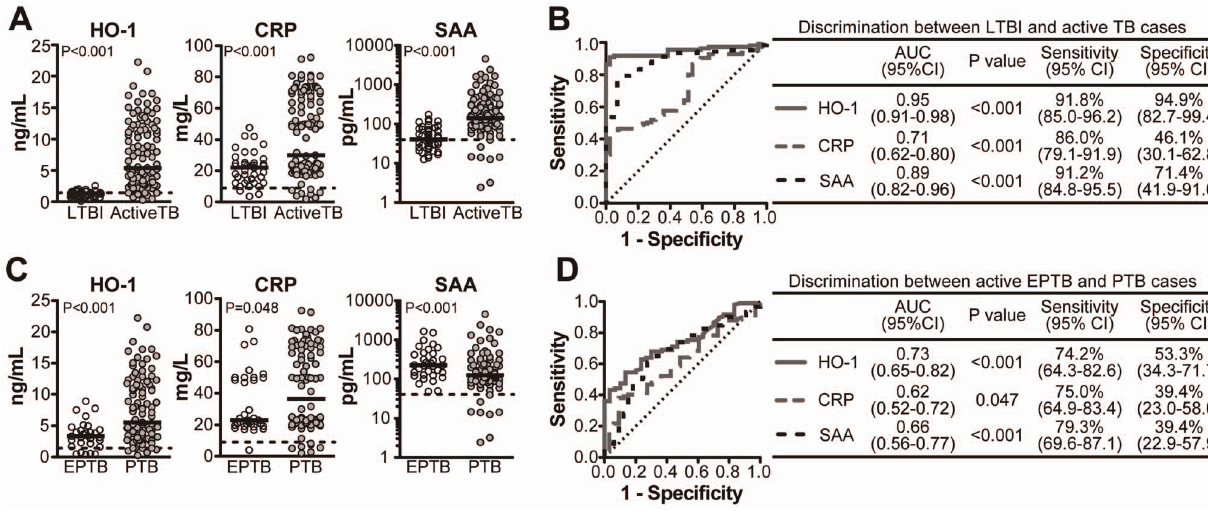
Figure 2. HO-1 as a candidate marker of active pulmonary tuberculosis. Levels of HO-1, C-reactive protein (CRP) and Serum Amyloid Protein-A (SAA) were compared between individuals with LTBI and active TB ( A ) or between patients with active EPTB and those with PTB (C) using the Mann Whitney test. The power of each of the three different biomarkers to discriminate the above clinical outcomes as analyzed by ROC curves is illustrated in ( B ) and ( D ). Symbols represent individual patients and bars represent median values. In ( A ) and ( C ), dotted lines represent median values from healthy donors. AUC, area under the curve; 95%CI, 95% confidence interval.